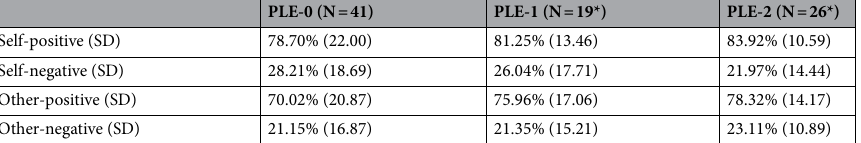
Table 2. Self-other task cognitive trait attribution results. SD = Standard Deviation; Mean percentage of “yes” responses in each category. No significant group differences were found. PLE-0 = control trajectory; PLE-1 = decreasing trajectory; PLE-2 = increasing trajectory. *Missing data for some participants in decreasing and increasing trajectory